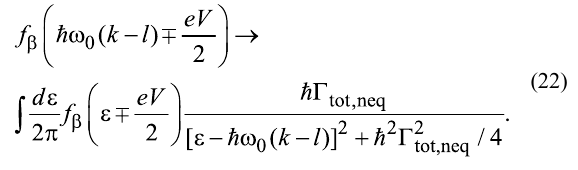
proved result for the steady state phonon distribution at a given voltage is evaluated working again with Equation 14, but using the replacement: